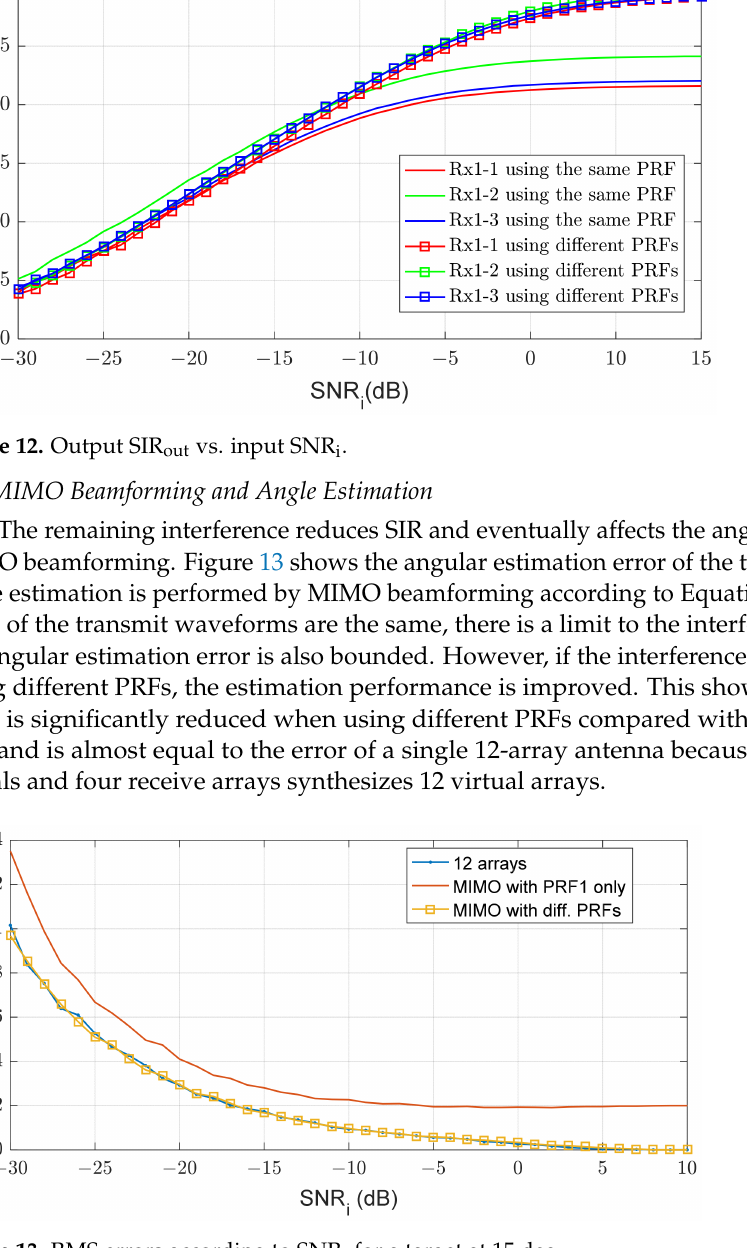
Figure 13. RMS errors according to SNR i for a target at 15